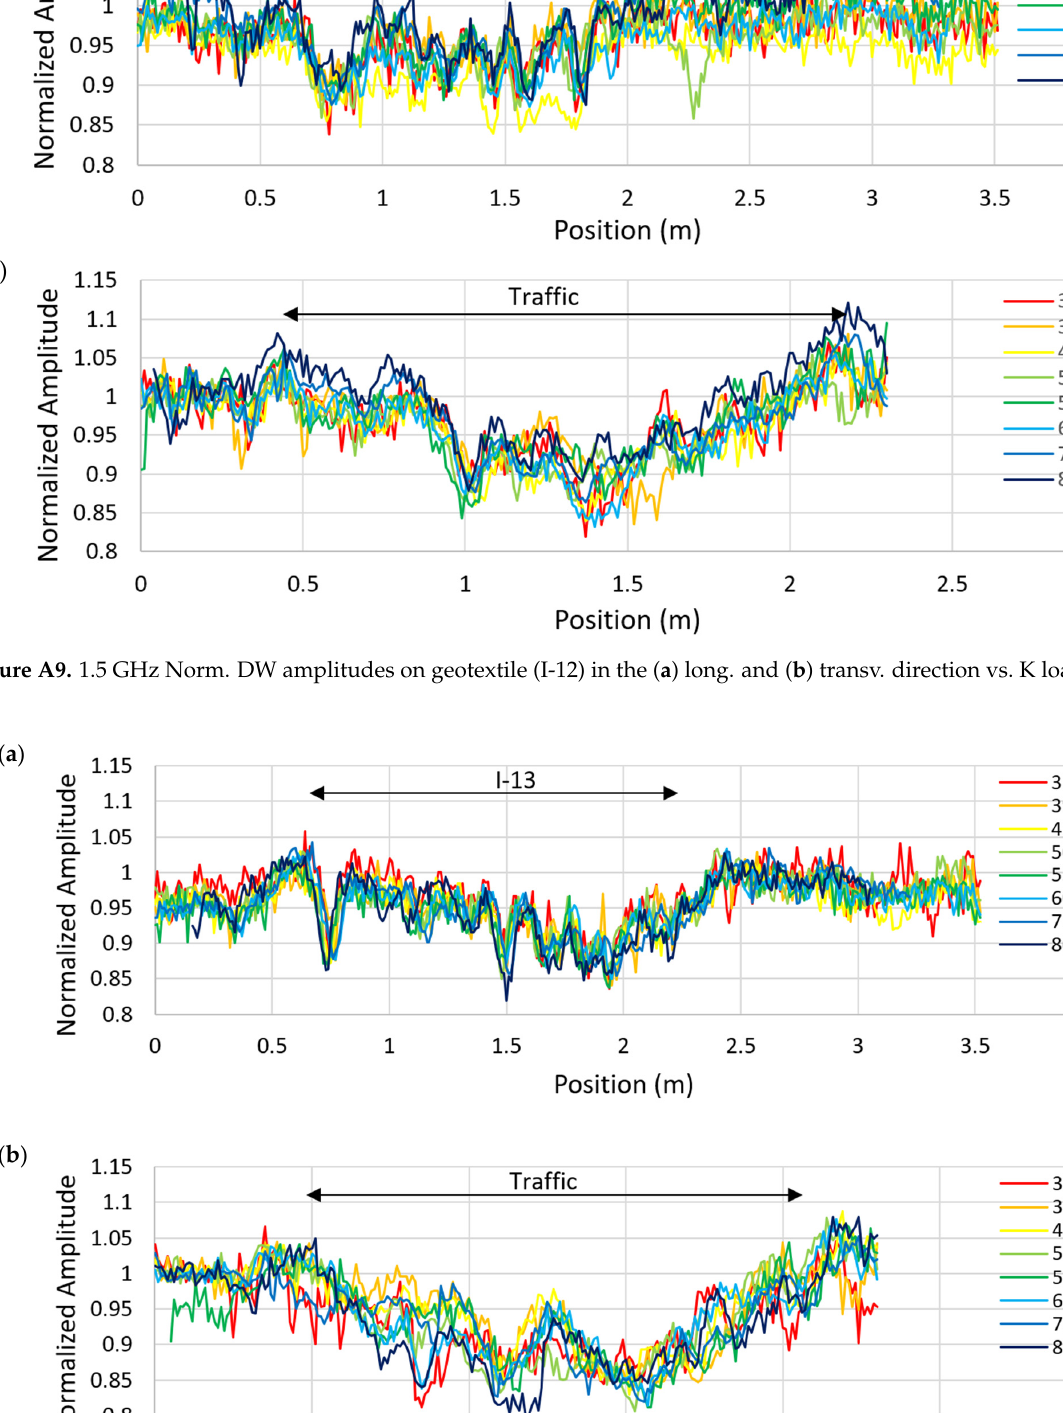
Figure A10. 1.5 GHz Norm. DW amplitudes on tack-coat free (I-13) in the ( a ) long. and ( b ) transverse direction vs. K loadings.